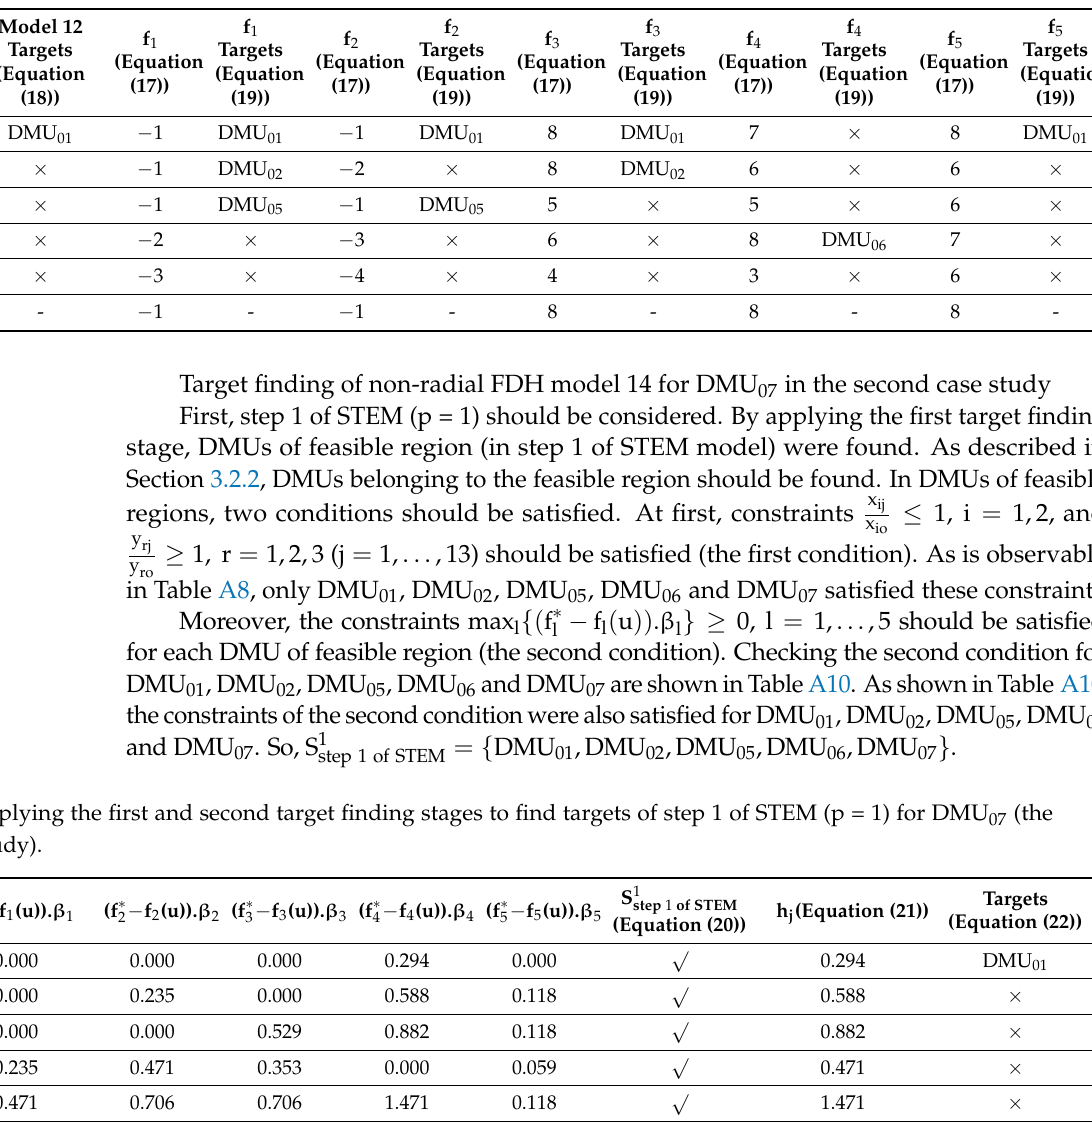
Table A9. Applying the second target finding stage for DMU 07 (the second case study).